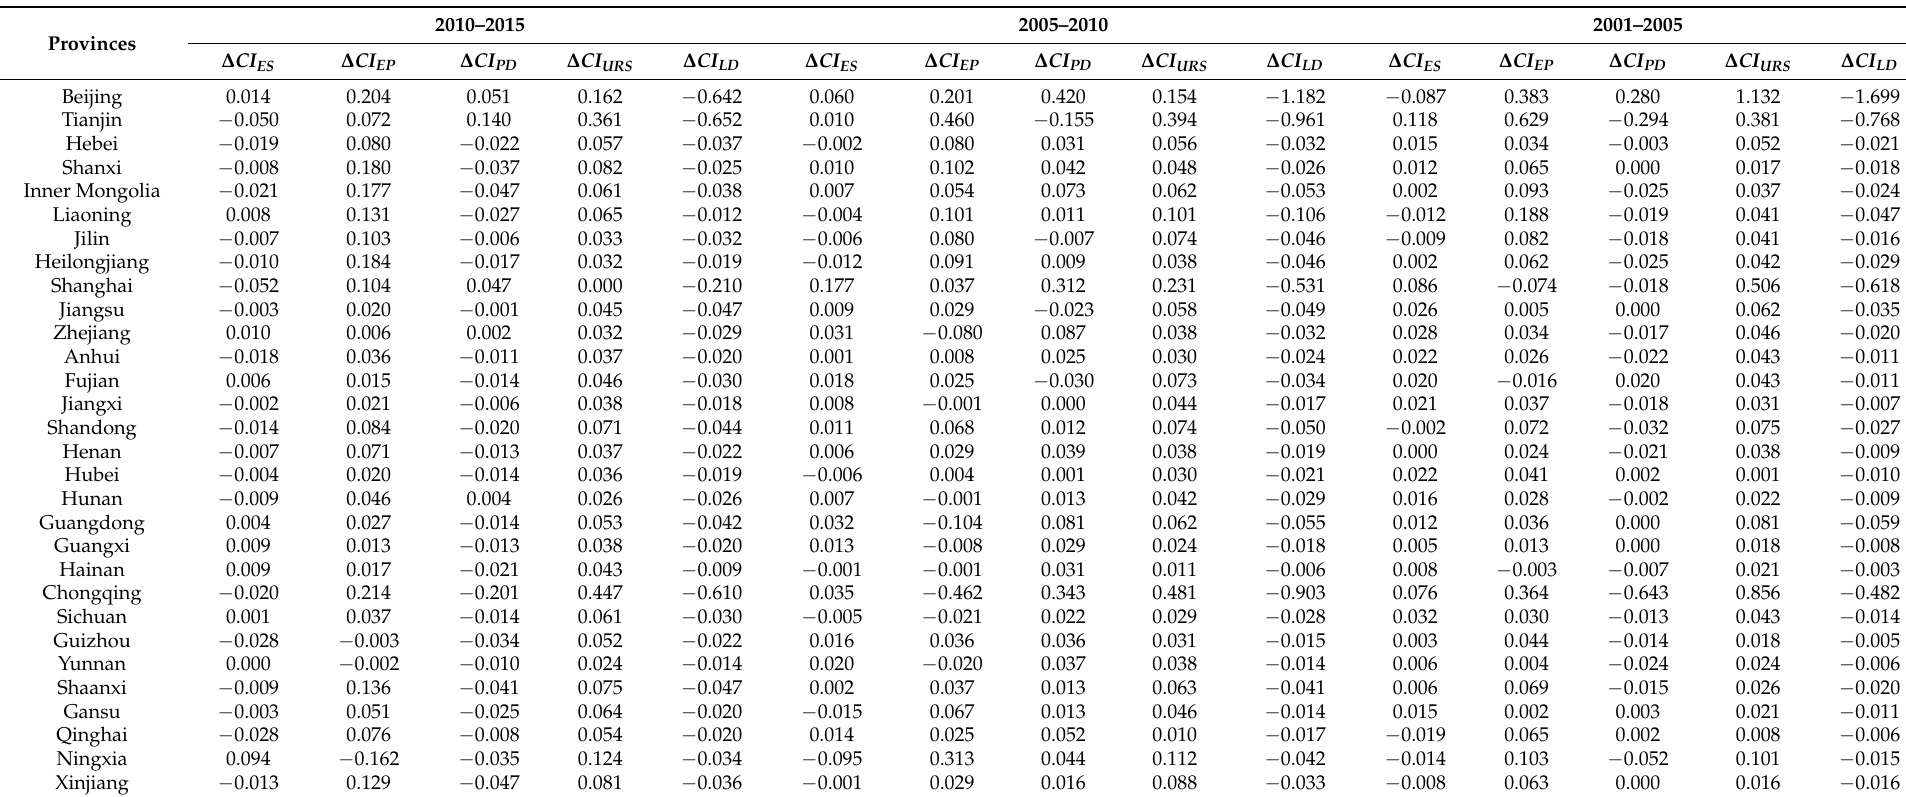
Table 2. Results of the decomposition analysis of carbon intensity on the provincial scale (tCO 2 /(10 4